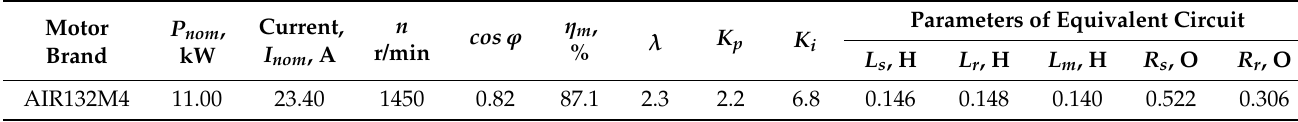
Table 1. Nameplate and calculation data for asynchronous motors.